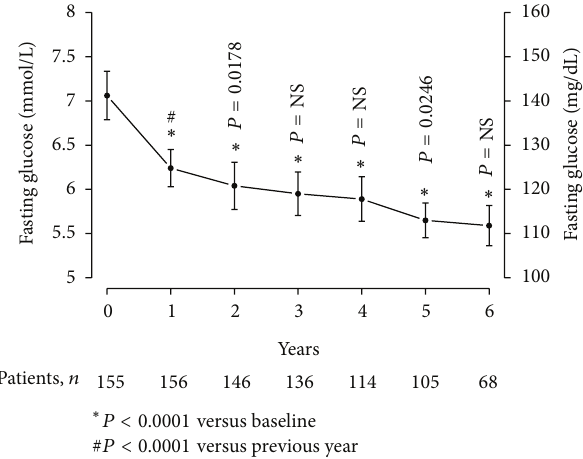
Figure 5: Fasting glucose (mg/dL or mmol/L) in 156 obese hypog- onadal men with type 2 diabetes mellitus treated with testosterone undecanoate injections for up to 6